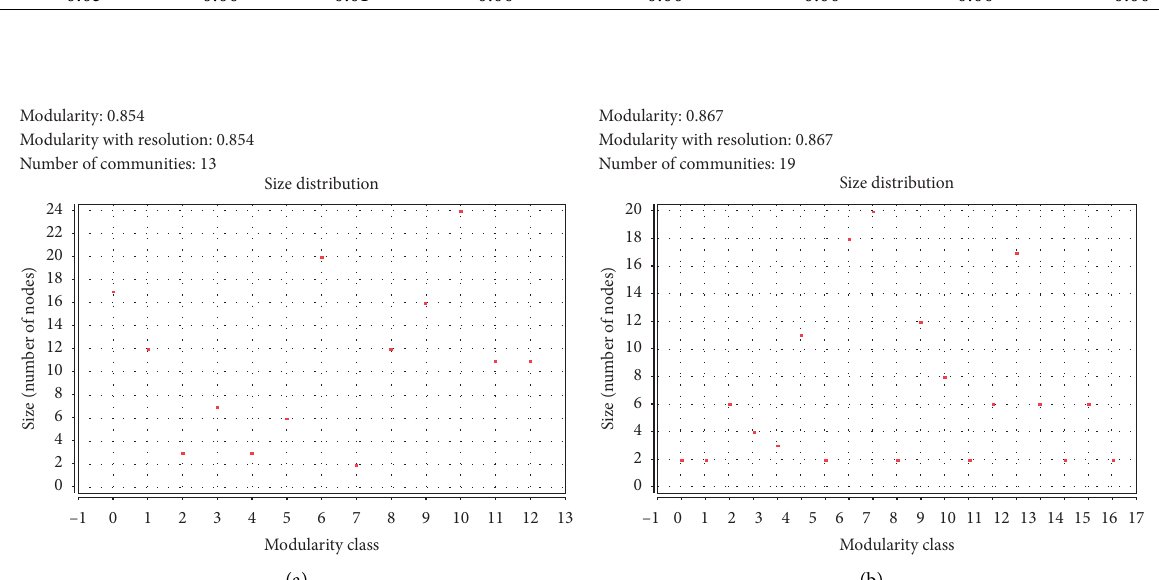
Figure 3: Modularization of community structure. (a) Modularity for online social support network. (b) Modularity for online social discussion network.